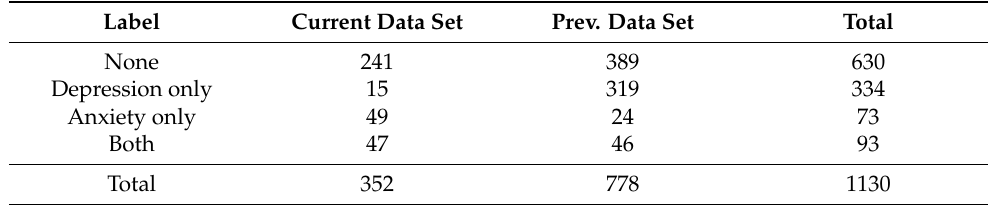
Table 4. Number of samples used to derive minimal assessment